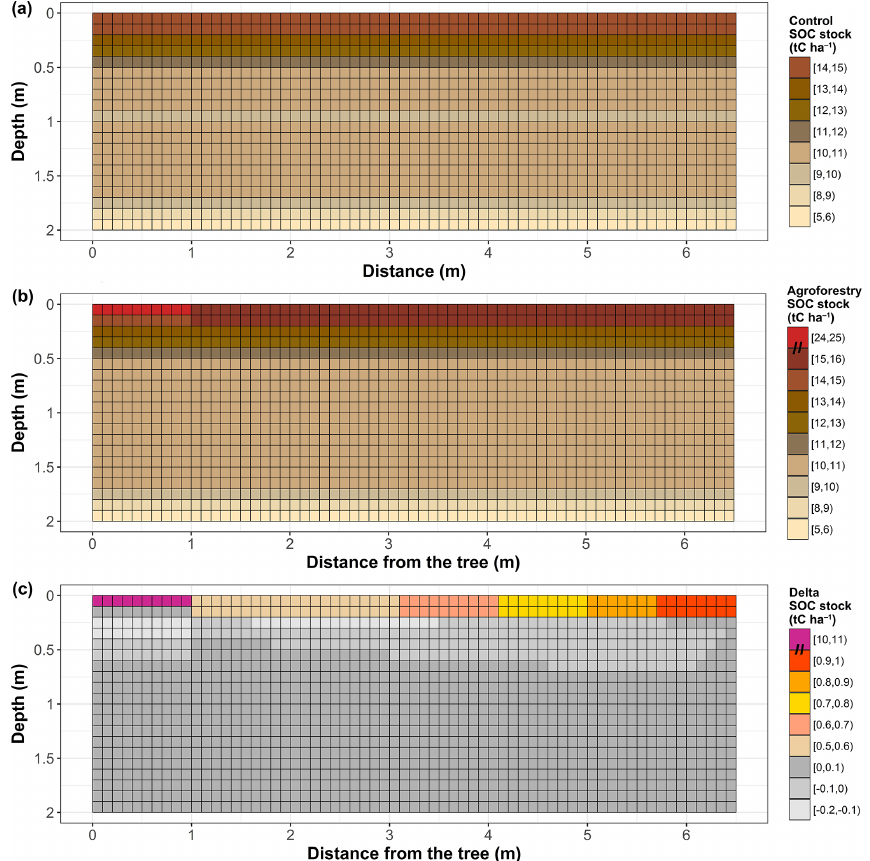
Figure 6. Spatial distribution of control SOC stocks (a) , agroforestry SOC stocks (b) , and additional SOC storage (tCha − 1 ) in an 18-year-old silvoarable system compared to an agricultural control plot and represented by the two-pool model with the priming effect (c) . The scales used in (b) and (c) are not continuous due to the large stocks predicted by the model in the top layer in the tree